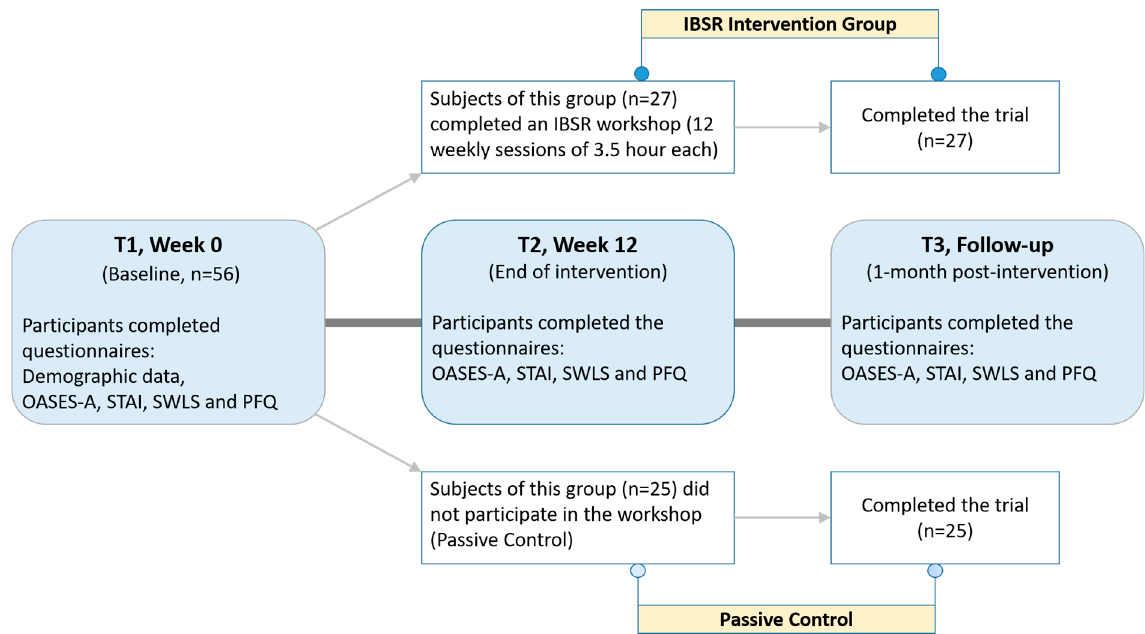
Figure 1. Study timeline. Participants were profiled at baseline ( T1 ) for their overall stuttering experience and other psychological indicators. They were then randomly assigned to IBSR or control groups and participated in either a 12-week IBSR intervention program or a 12-week passive control group. Psychological indicators and overall stuttering experience were assessed again at study-week 12 ( T2 ) and 1 month after the end of the intervention ( T3 ). IBSR = Inquiry Based Stress reduction. OASES-A = Overall Assessment of the Speaker’s Experience of Stuttering-Adults. STAI = State–Trait Anxiety Inventory. PFQ = Psychological Flexibility Questionnaire. SWLS = Satisfaction-with-Life Scale.